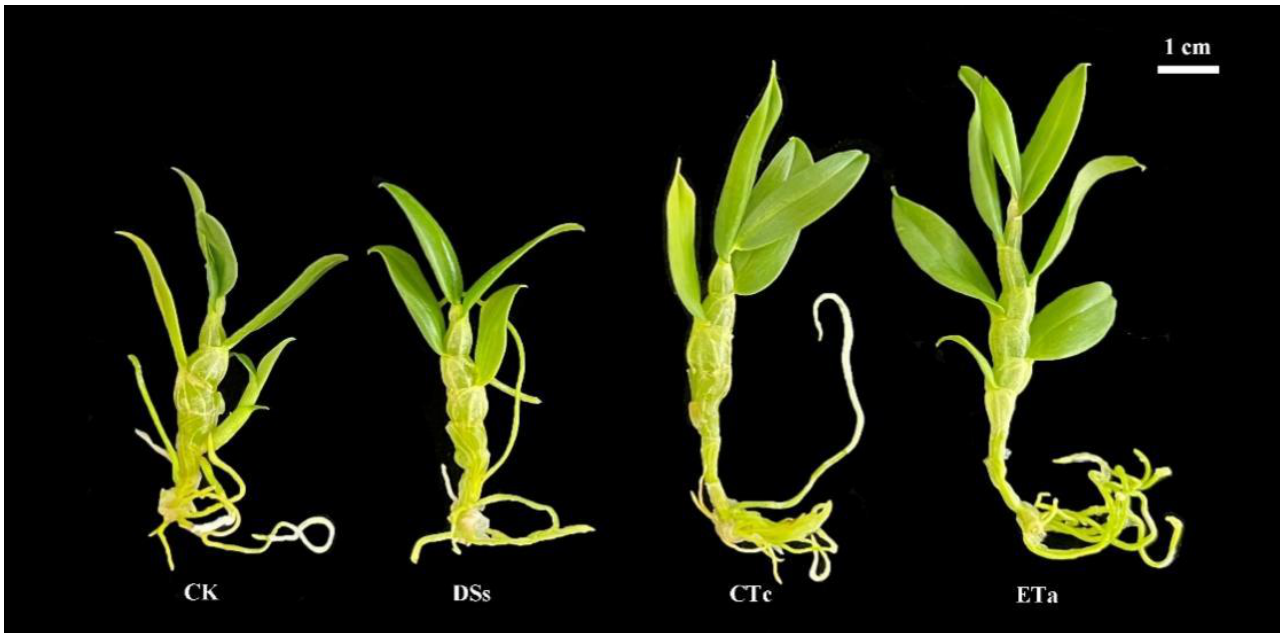
Figure 3. Comparison of growth of tissue-culture seedlings of D. officinale . Seedlings from the groups CK, DSs, CTc and ETa are shown from left to right.